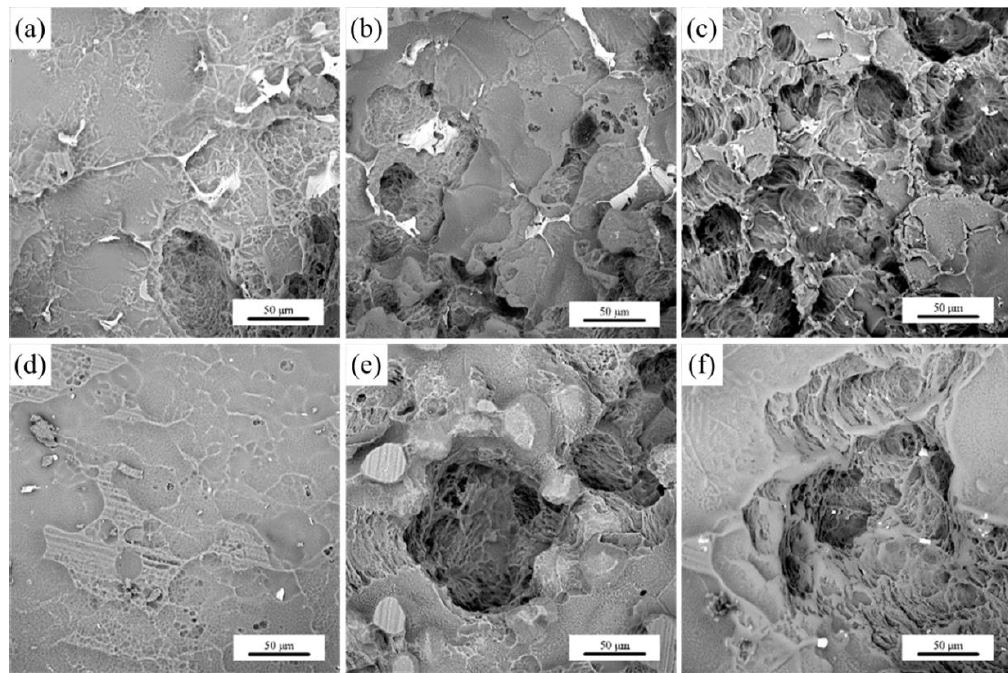
Figure 9. Surface morphologies of Mg-xGd alloys after surface corrosion: ( a ) Mg-1Gd (AC), ( b ) Mg-3Gd (AC), ( c ) Mg-5Gd (AC), ( d ) Mg-1Gd (ST), ( e ) Mg-3Gd (ST), and ( f ) Mg-5Gd (ST).